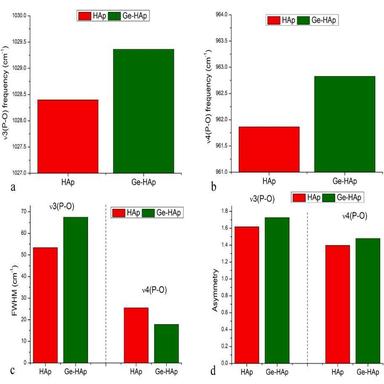
Peak frequencies of the two dominant vibration modes in the FTIR spectra of HAp and Ge-HAp: the antisymmetric ν3 stretch (a) and the antisymmetric ν4 bend (b). The difference in the FWHM (c) and the asymmetry (d) of these two vibration modes for HAp and Ge-HAp.